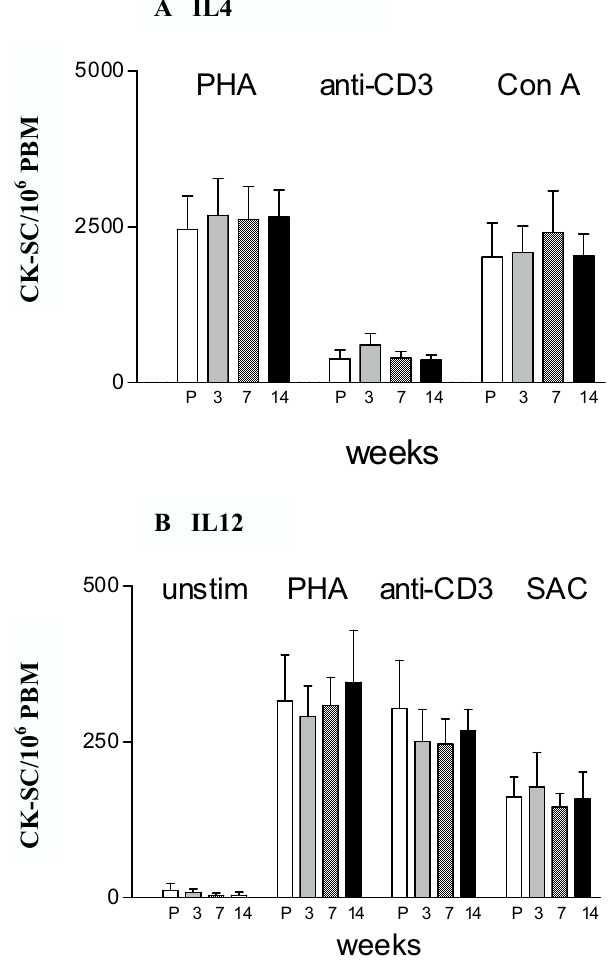
Figure 1 Numbers of IL4 (A) and IL12 (B) cytokine-secreting cells (CK-SC) per 10 6 peripheral blood mononuclear cells (PBM) measured by ELISPOT assay in 19 healthy volunteers before starting Qigong training (P) and after 3, 7 and 14 weeks of practice. There were no significant changes during the study